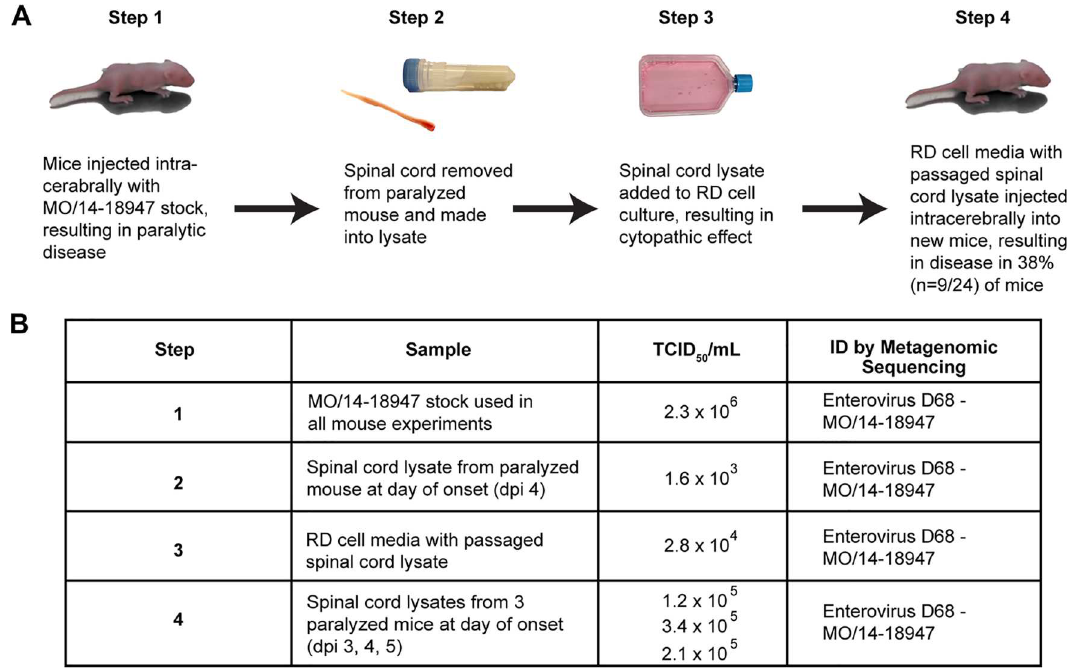
Fig 6. Fulfillment of Koch’s postulates establishes a causal role for EV-D68 in paralytic disease. ( A ) Steps taken to fulfill Koch’s postulatesin the EV-D68 mouse model of AFM. Mice were infected with MO/14-18947 by intracerebral injectionand monitored daily until the onset of paralysis(Step 1). The wholespinal cord of a paralyzedmouse was removed and mechanically lysed (Step 2). The spinalcord lysate was then inoculated into a flask of RD cells (Step 3). After the appearanceof cytopathic effect, the RD cell media with passagedspinal cord lysate was collectedand syringefiltered. The filtered media with passagedspinal cord lysate was then injected intracerebrally into na ï vemice (Step 4). 38% (n = 9 out of 24) of these mice developed signs of paralysis.Spinal cords from several paralyzedmice (n = 3 out of 3) in Step 4 were removed and examinedby TCID 50 and metagenomic sequencing for the presenceof EV-D68. ( B ) TCID 50 analysis revealedinfectiousvirus confirmed to be MO/14-18947by metagenomic deep sequencing identification for each step in the fulfillment of Koch’s